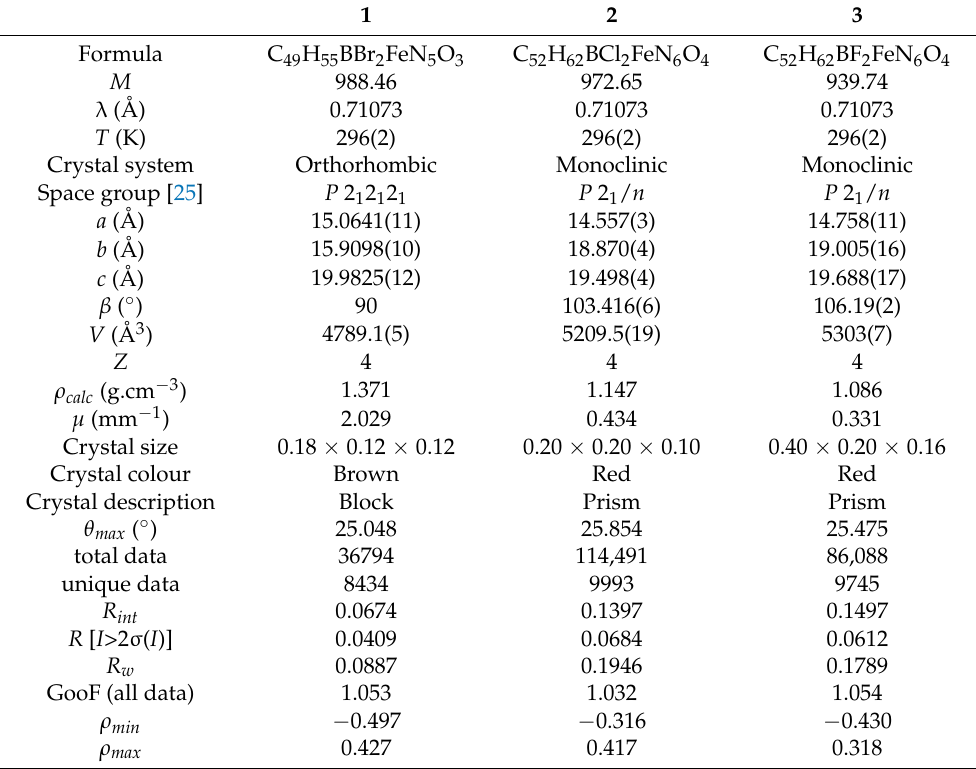
Table 1. Crystallographic data and refinement details for structures 1 , 2 and 3 at room